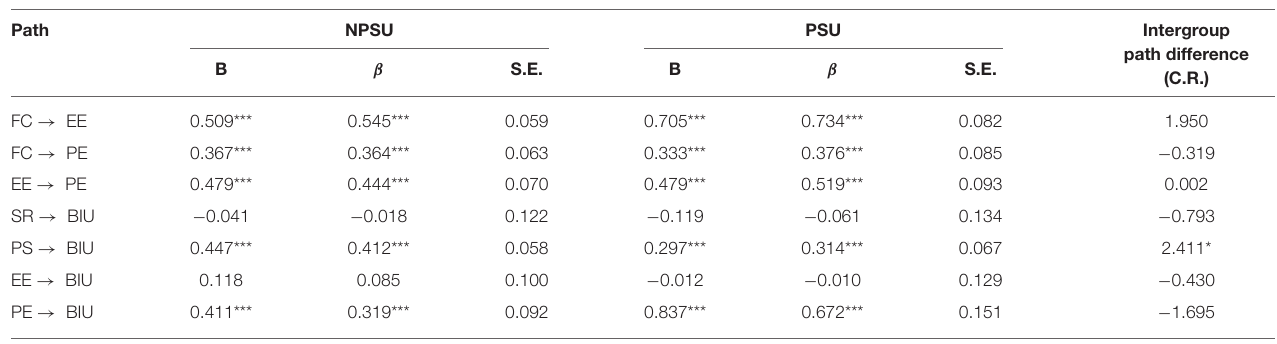
TABLE 5 | Multigroup path